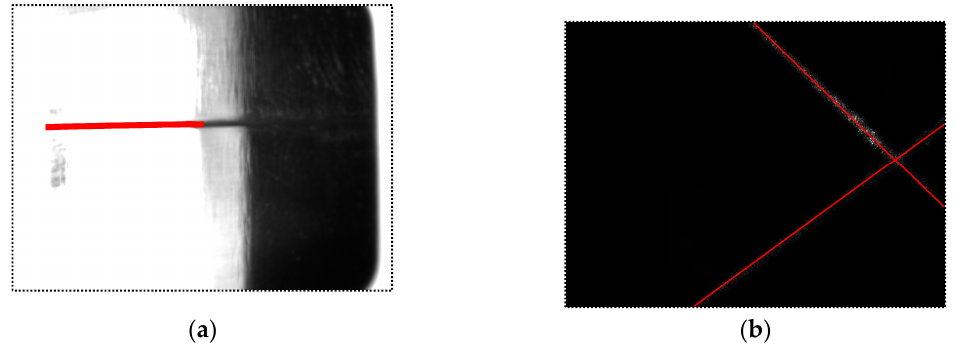
Figure 20. Image processing results. ( a ) Image processing results of Figure 19k; ( b ) Image processing results of Figure 19d.